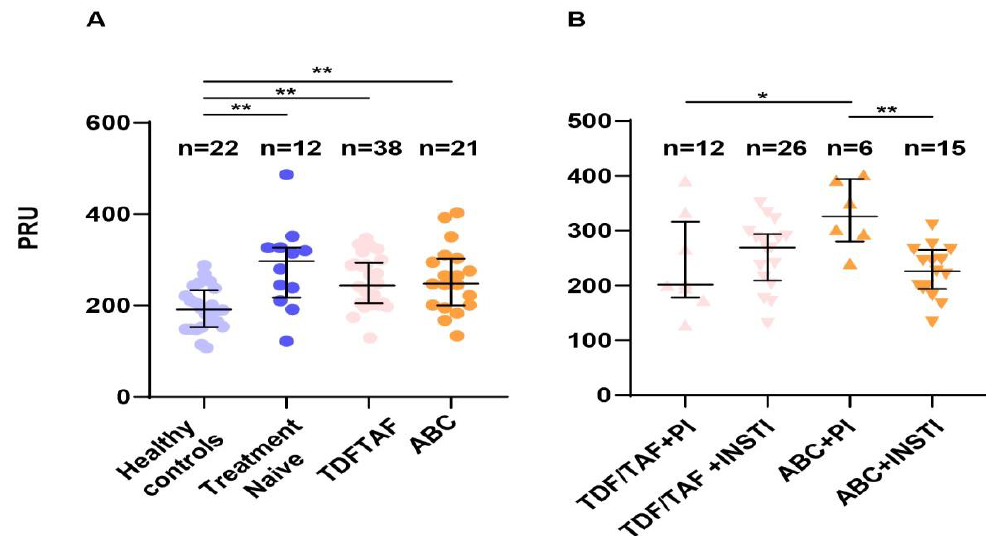
Figure 2. Platelet reactivity measurements ( A ). Platelet reactivity was significantly increased in PLWHIV compared to healthy controls. No differences were noted within treatment groups ( B ). PLWHIV receiving the combination of ABC + PI presented significantly increased platelet activation compared to patients on TDF/TAF + PI or ABC + INSTI. TAF: tenofovir alafenamide, TDF: tenofovir disoproxil fumarate, ABC: abacavir, PI: protease inhibitor, INSTI: integrase strand transfer inhibitor; PRU: platelet reactivity units; ** denotes p < 0.01, * p < 0.05.